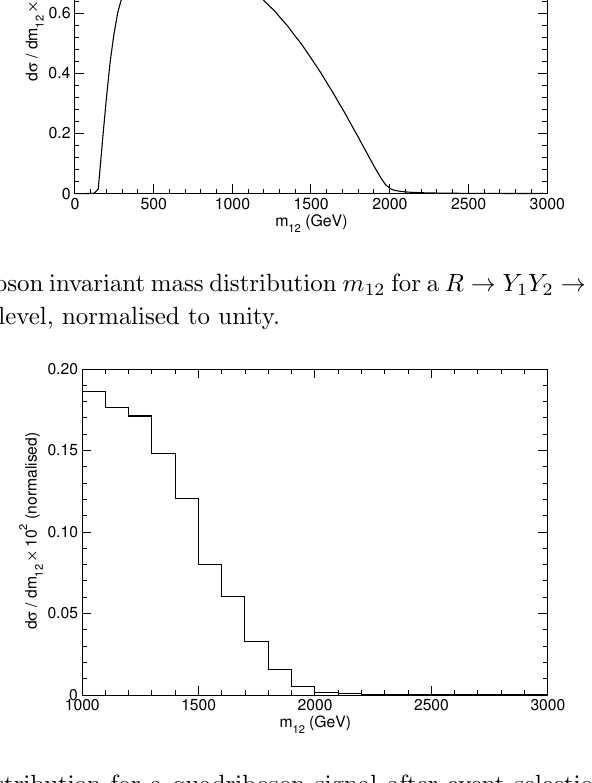
Figure 6 . Sample distribution for a quadriboson signal after event selection (see the text), nor- malised to